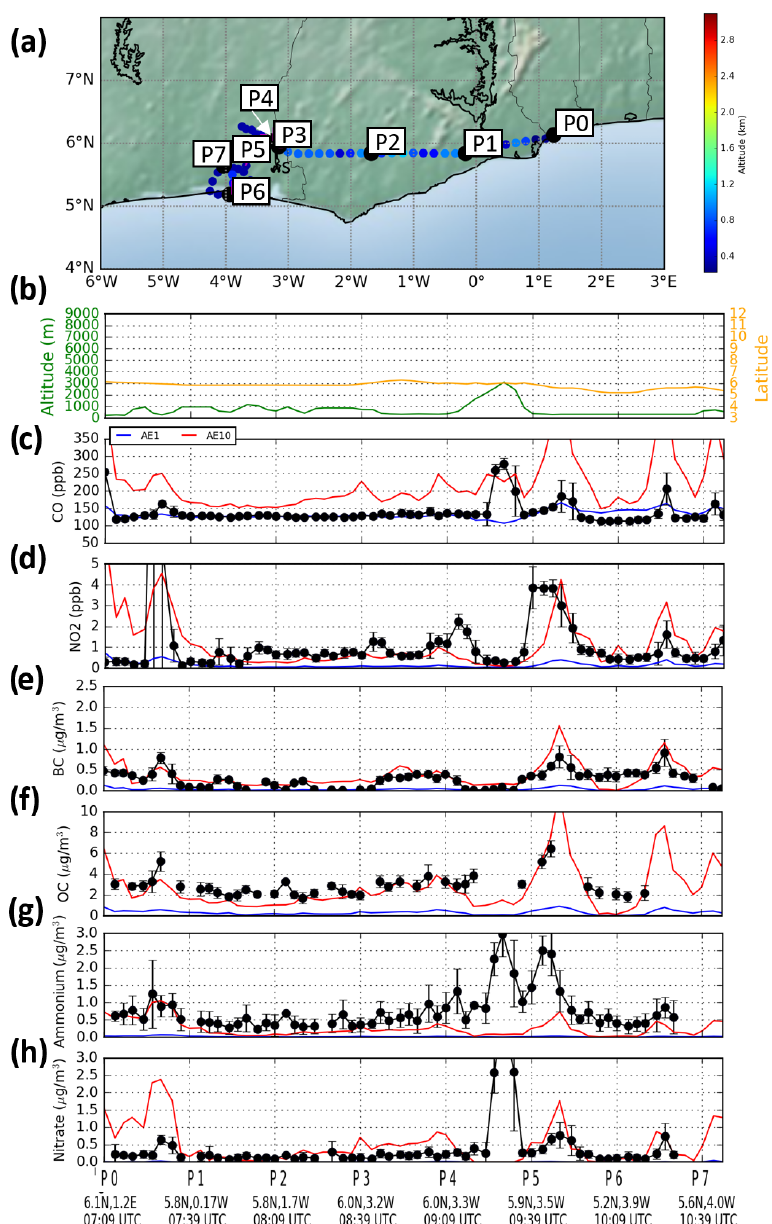
Figure 2. (a) Map of the flight spatial trajectory of the ATR-42 research aircraft data on 6 July 2016, and time series composed of seven parts (from the top to the bottom): (b) the altitude (in ma.m.s.l.) with the latitude (in ◦ N); (c–h) the six other panels present the modeled values interpolated along the flight positions for the two experiments, AE1 (blue line) and AE10 (red line), and the 3min averaged observations (black points and the associated standard deviation with the error bars) of: (c) carbon monoxide (CO in ppb), (d) nitrogen oxides (NO 2 in ppb), (e) black carbon (BC in µgm − 3 ), (f) organic carbon (OC in µgm − 3 ), (g) ammonium (in µgm − 3 ), (h) nitrate (in µgm − 3 ). Aerosol concentrations are measured with a cut-off diameter of 1µm and the modeled concentrations are shown